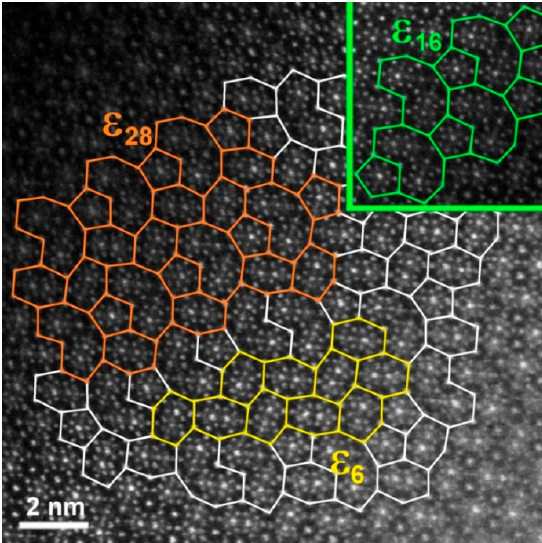
Figure 4. A high-angle annular dark-field (HAADF)/STEM image of the atomic structure of the as- solidified Al 74 Pd 12 Co 14 alloy. Phason tiles, i.e., hexagon, pentagon, and banana-shaped nonagons, are highlighted by solid lines. Yellow, green, and orange structural motifs correspond to ε 6 , ε 16 , and ε 28 , respectively. For the color interpretation of this figure, the reader is referred to the web version of this article.